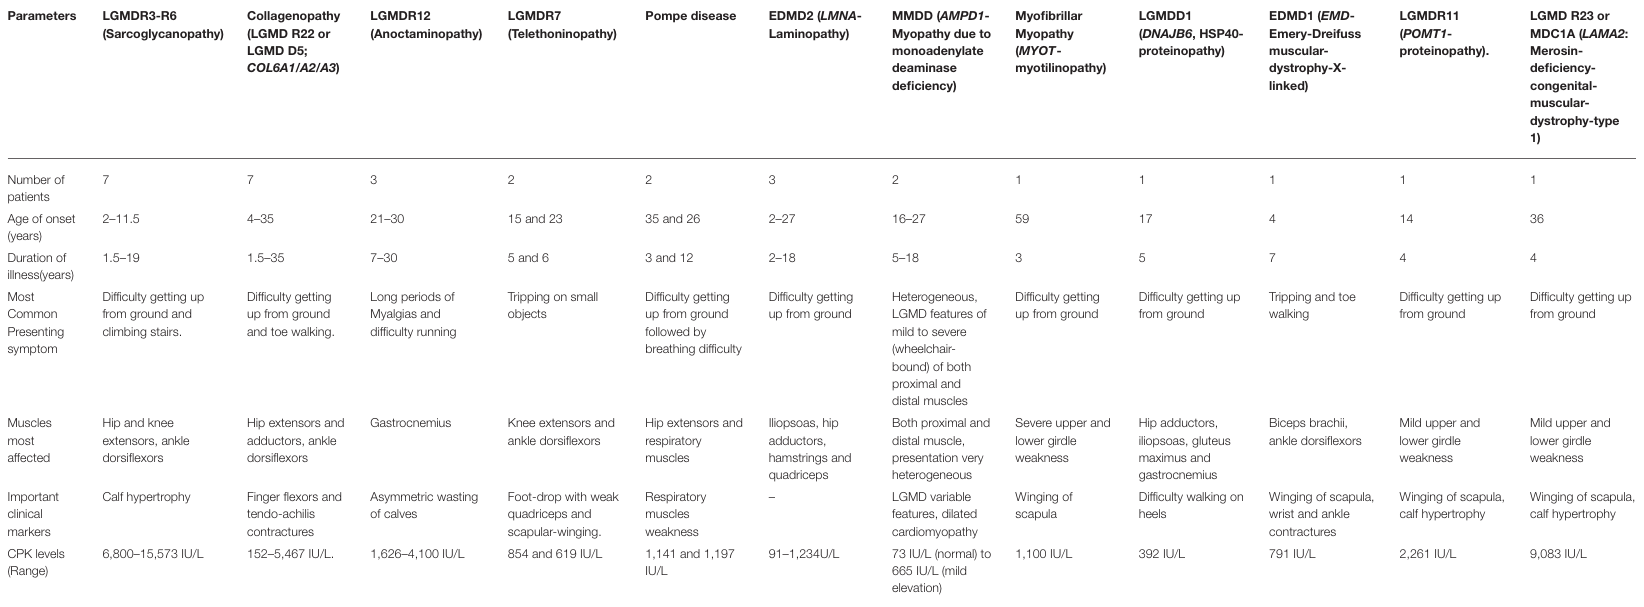
TABLE 4 | Clinical features of uncommon